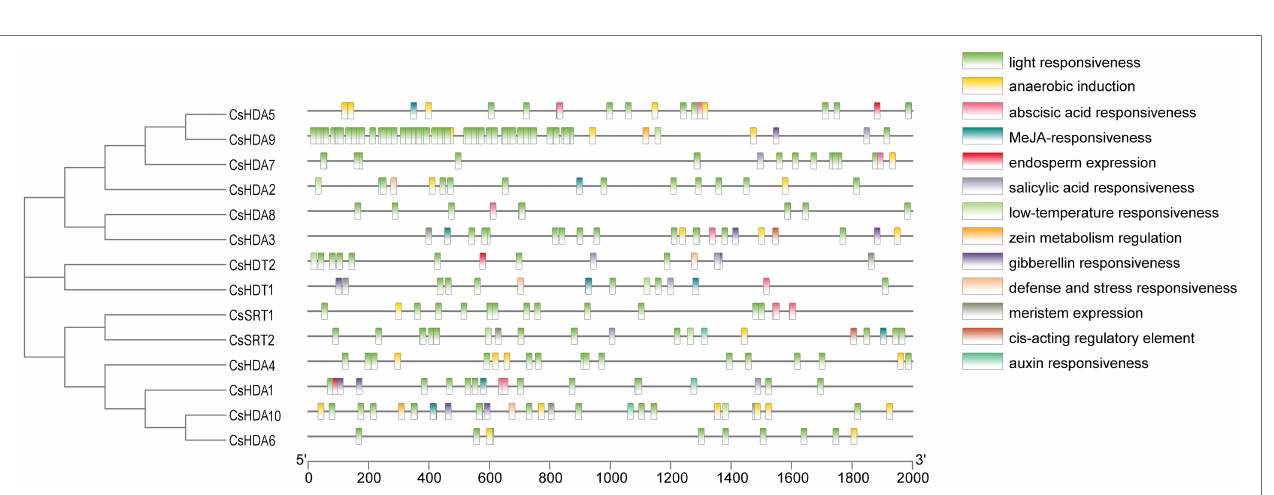
FIGURE 4 | (A) Chromosomal locations of the CsHDAC genes. The y axis shows the length of the chromosome (unit: bp). (B) Synteny analysis of HDAC genes between Cannabis sativa and A. thaliana . The red triangle side indicates the position of the HDAC gene on the chromosome. The blue lines represent the syntenic HDAC gene pairs.